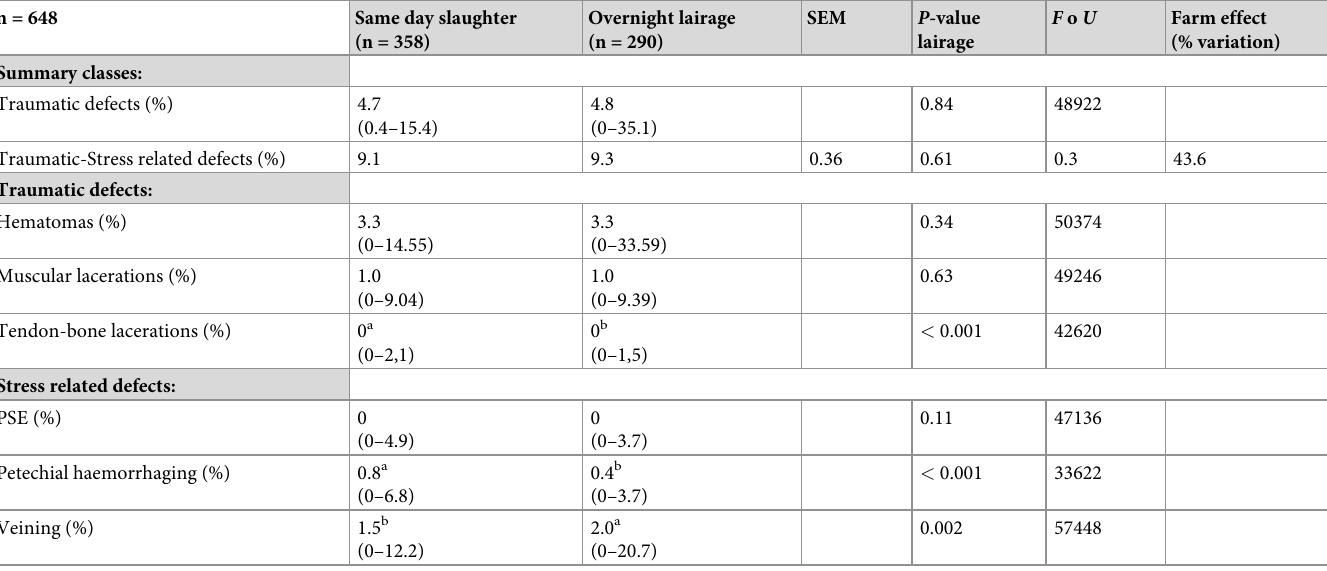
Table 4. Effect of lairage on the prevalence of different ham defects detected in 648 batches of PDO Italian heavy